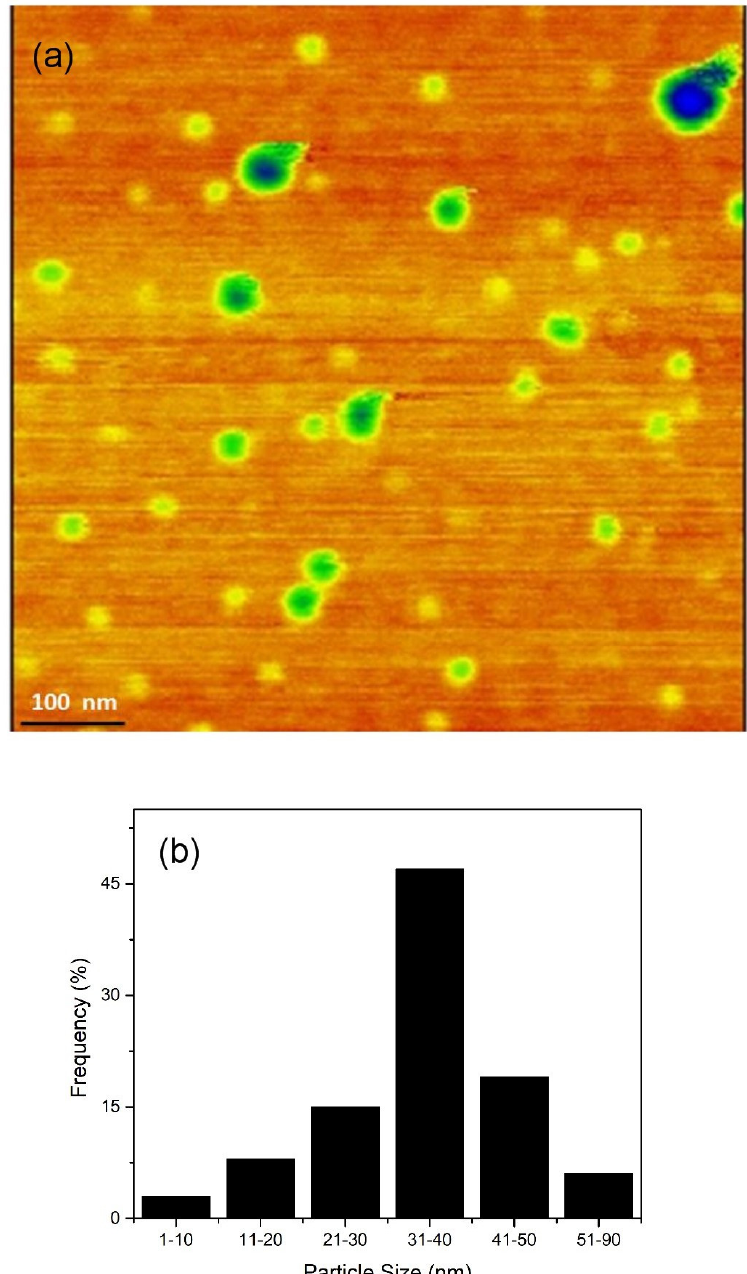
Figure 2. ( a ) AFM image of Ferene-S-AgNPs and ( b ) Particle-size distribution histogram of Ferene-S-AgNPs.